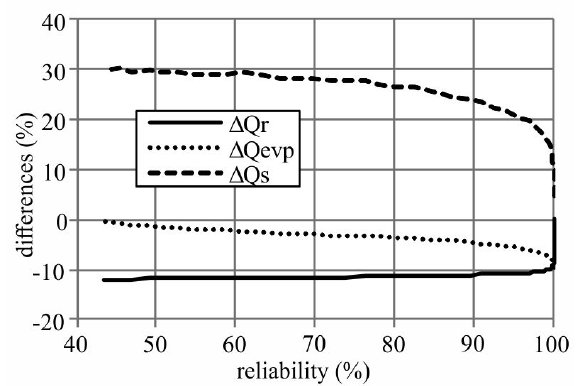
Figure 11. Difference between the main water-balance variables in the Pentecoste reservoir as a function of the annual reliability: ∆ Q r = [ Q CBS r − Q BRS r